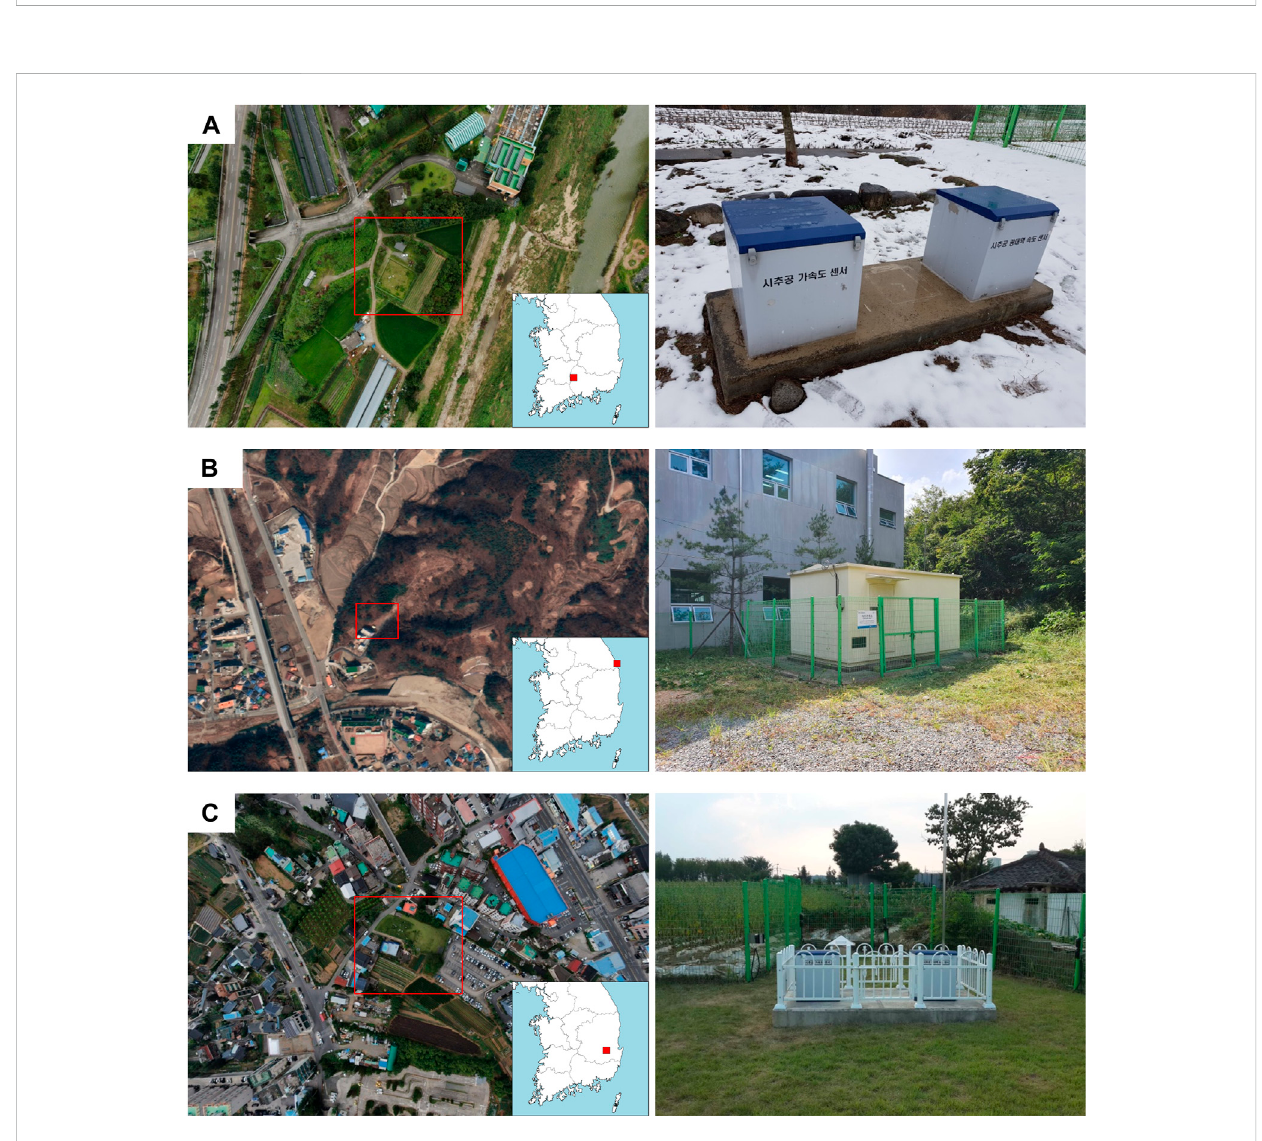
Satellite and frontal photographs at (A) HAMB, (B) IMWB, and (C) YOCB